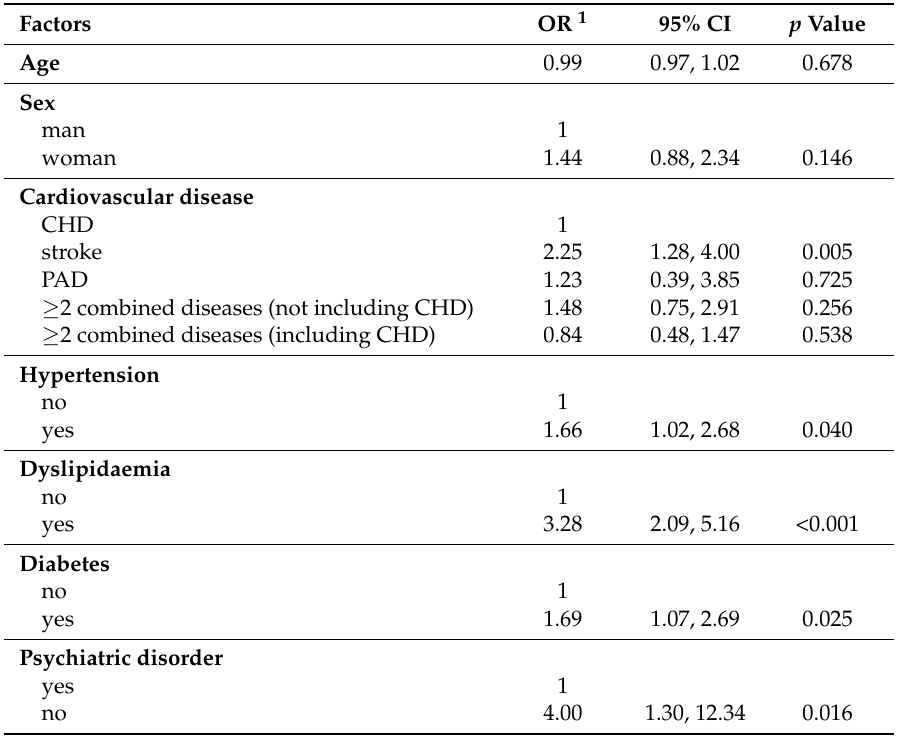
Table 4. Association between adherence to European clinical practice guidelines (CPGs) for preventing cardiovascular disease and sociodemographic and morbidity